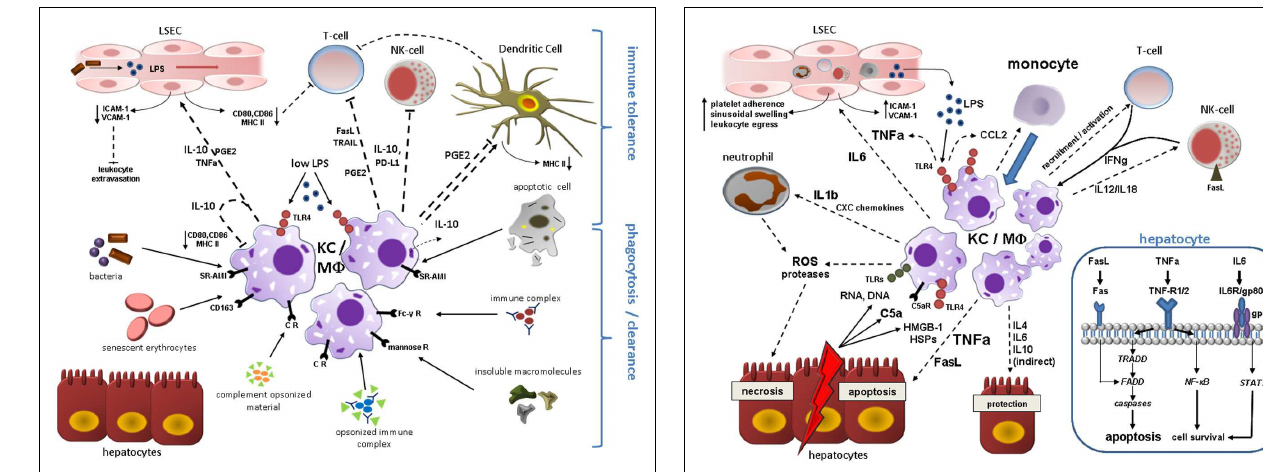
FIGURE 2 | Kupffer cell (KC)/Macrophage (M Φ ) contribution to acute liver injury. Acute hepatocyte damage in response to multitude events leads to release of various DAMPs including HSPs and HMGB-1, which bind toTLR4 on KCs, and other cell contents (RNA, DNA) binding to various TLRs.TLR4 engagement activates NF- κ B pathways in KC resulting in the synthesis of a myriad of proinflammatory cytokines, chemokines, reactive oxygen, and nitrogen species. KC-secretedTNF-alpha is central in the augmentation of liver injury mainly by inducing hepatocyte apoptosis,